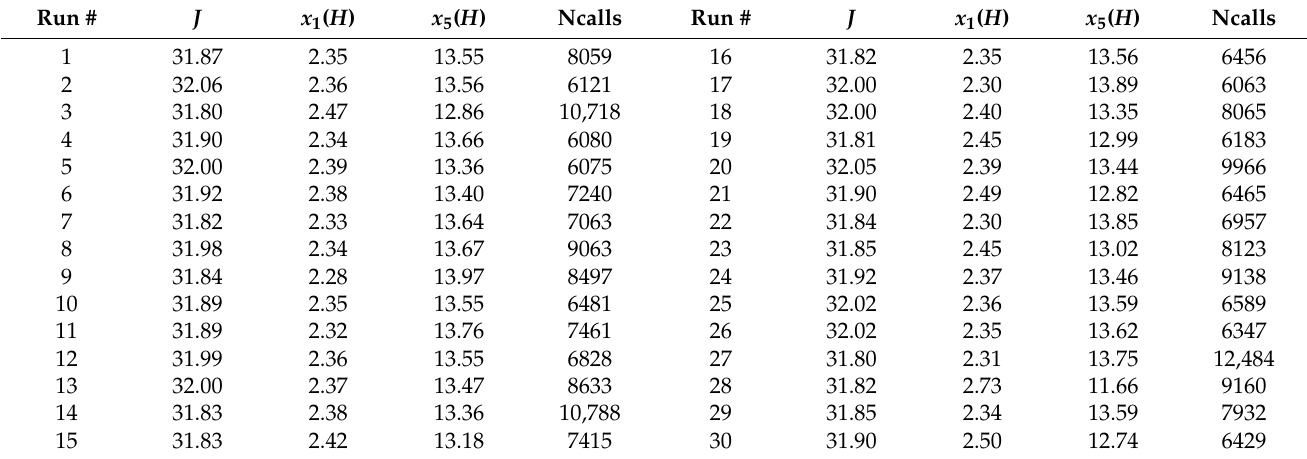
Table 1. Results of the simulation series for RHC_EA without control input range estimation.